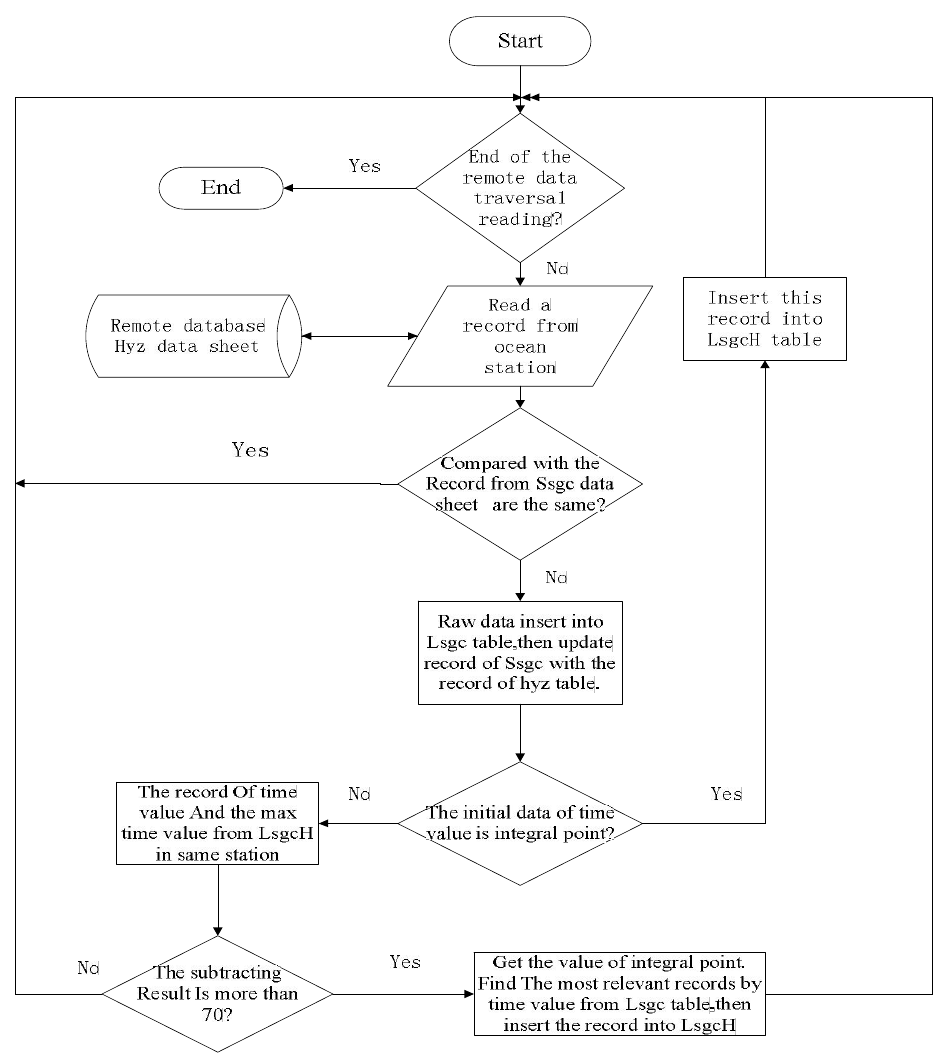
Figure 2. The update process of the observation information